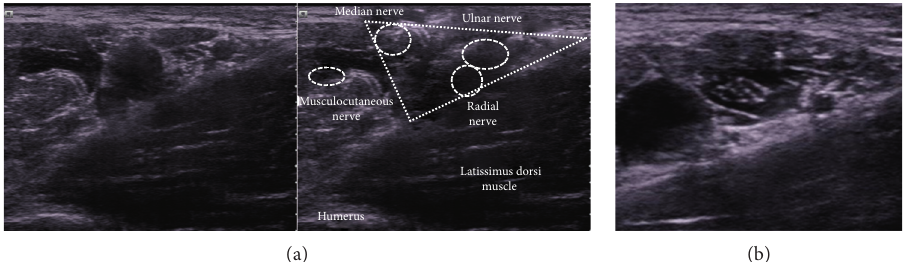
Figure 5: (a) In the axillary view, finding the triangle surrounded by the coracobrachialis and latissimus dorsi muscles helps identify the nerves. The median, ulnar, and radial nerves pass through inside the triangle. (b) Hypoechoic anesthetics are injected all around the nerve.